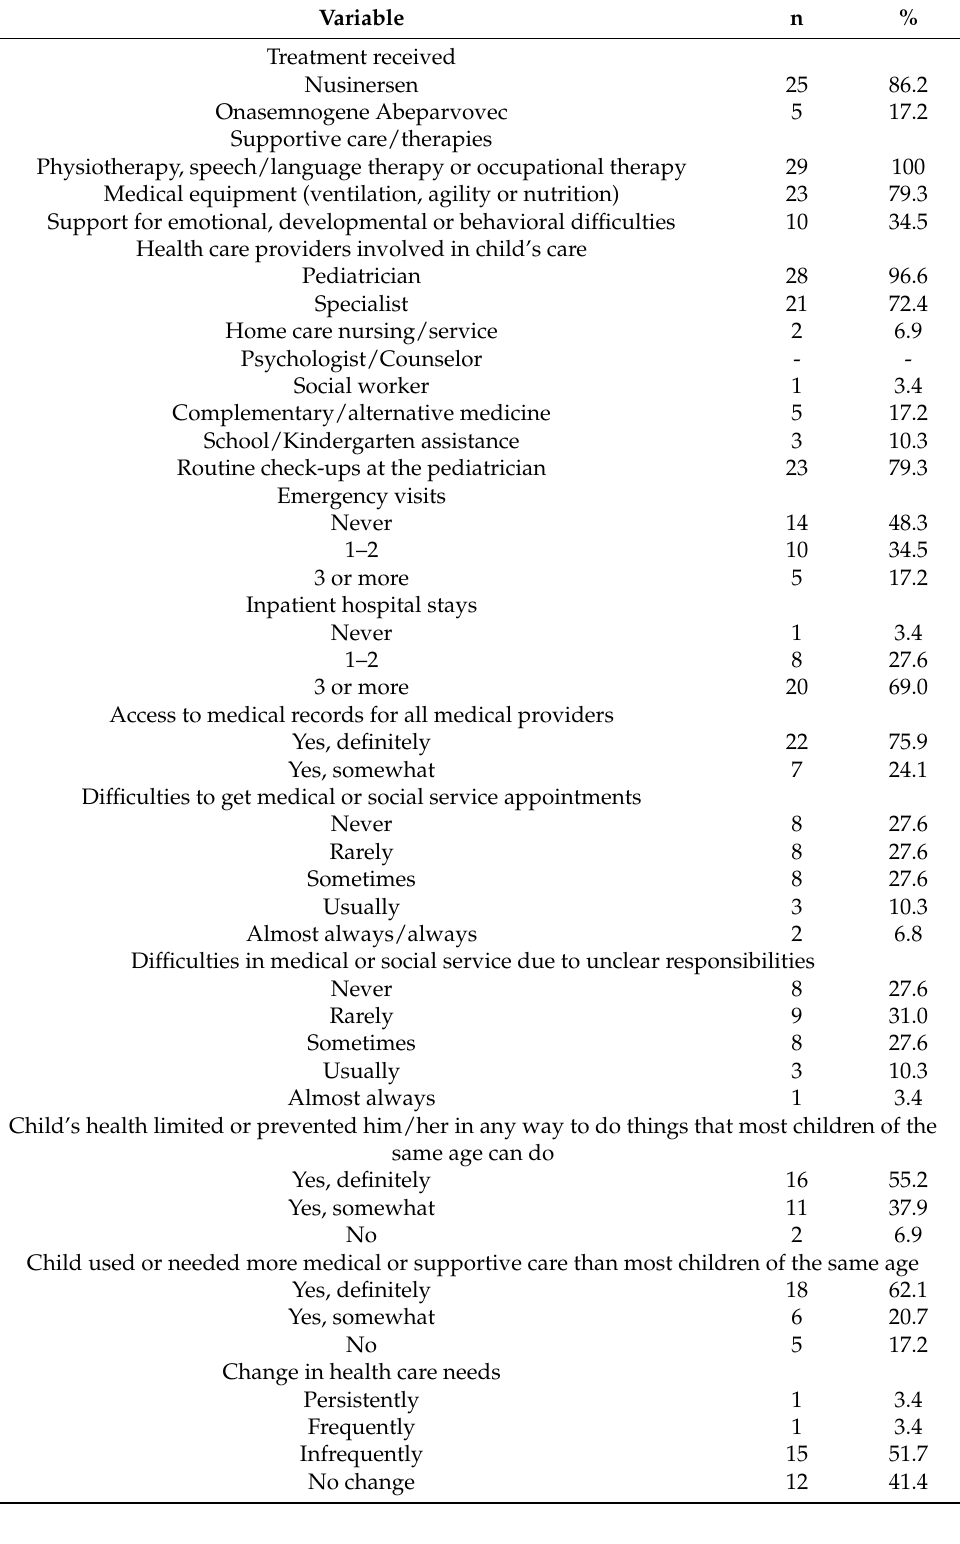
Table 2. Health care usage and child’s health status in the 12 months prior to the study (total n =